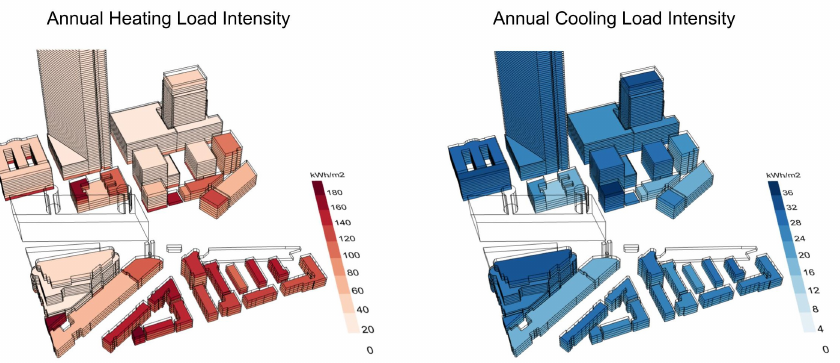
Figure 6. Example Dragonfly spatial visualizations where geometry is colored based on simula- tion